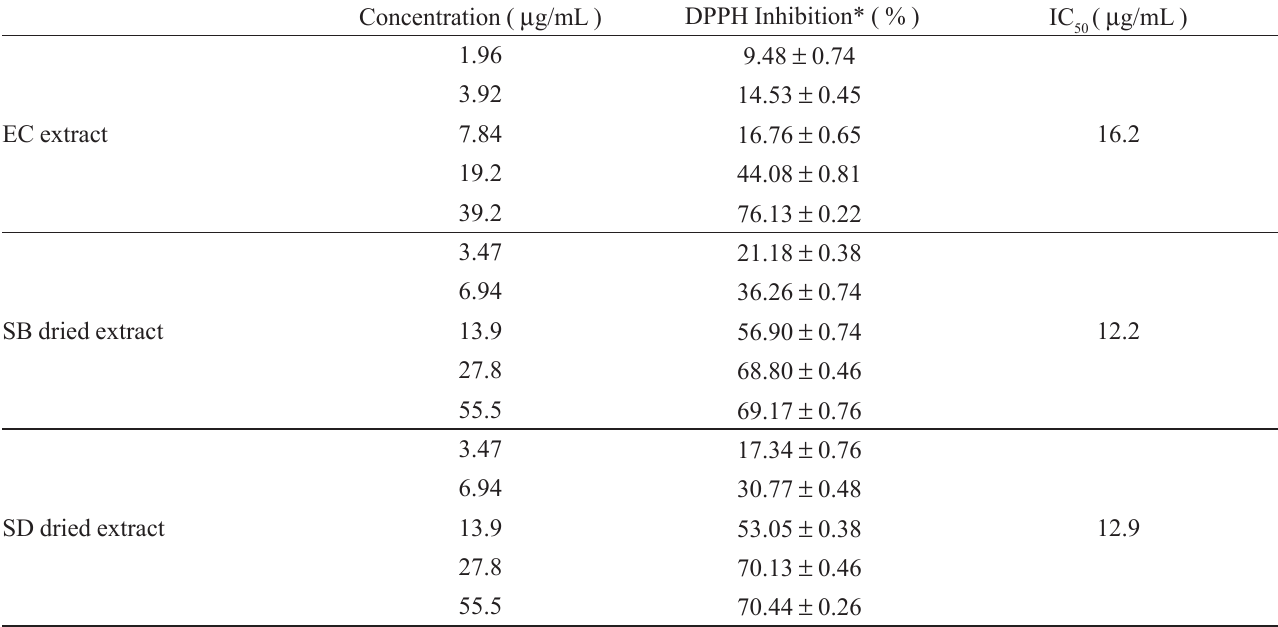
TABLE IV - Antiradical activity of Bauhinia forficata extracts observed with DPPH Concentration ( m g/mL )